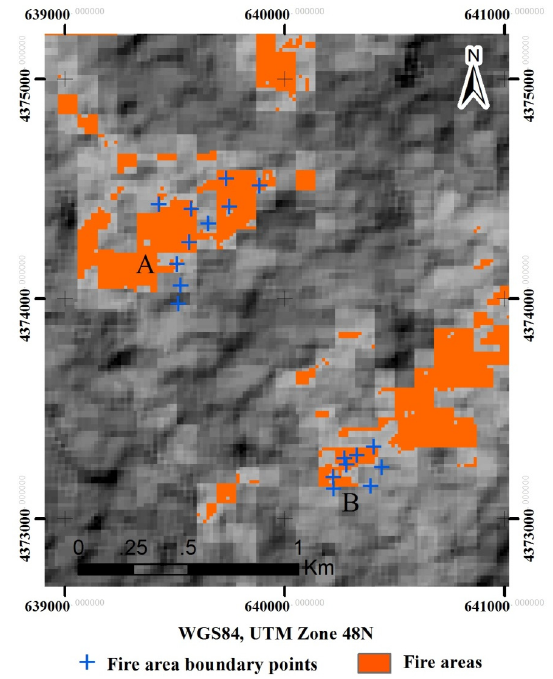
Figure 11. Locations of landscape features indicative of coal fire boundaries (blue crosses) and coal fire areas (orange) from our self-adaptive gradient-based thresholding (SAGBT) method. ASTER TIR image (22 June 2013) is used as